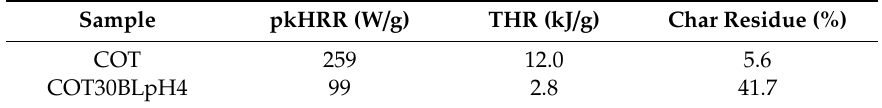
Table 19. Results from microscale combustion calorimetry for untreated cotton and cotton treated with 30 bi-layers at pH = 4.